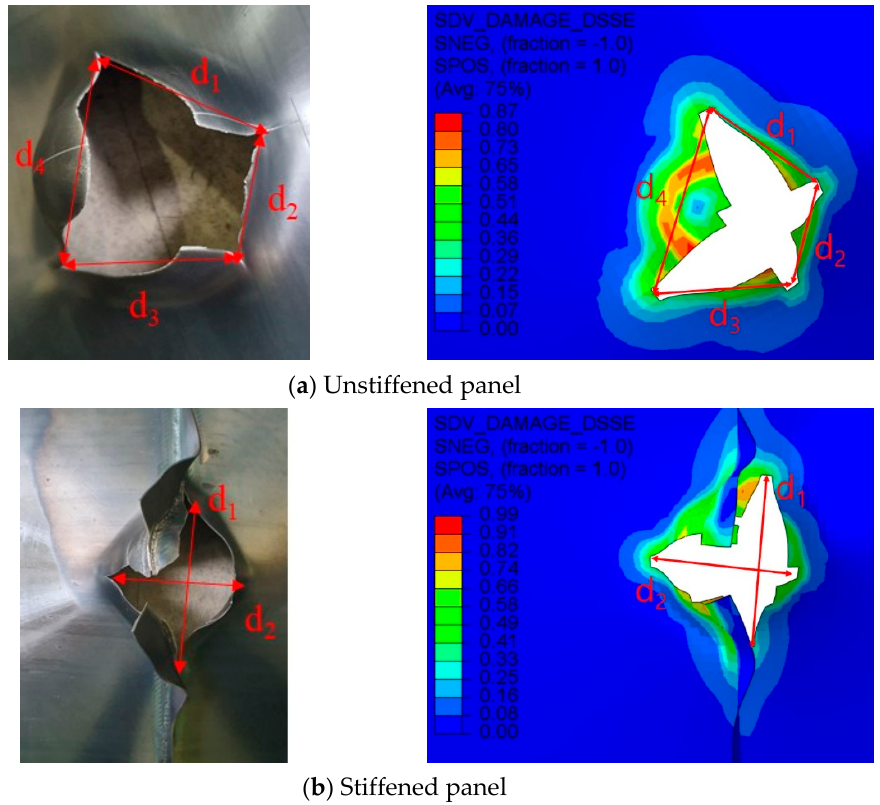
Figure 16. Comparison of experimental and numerical post-fracture shapes. Table 4. Measurement of failure surface of experimental and numerical results.